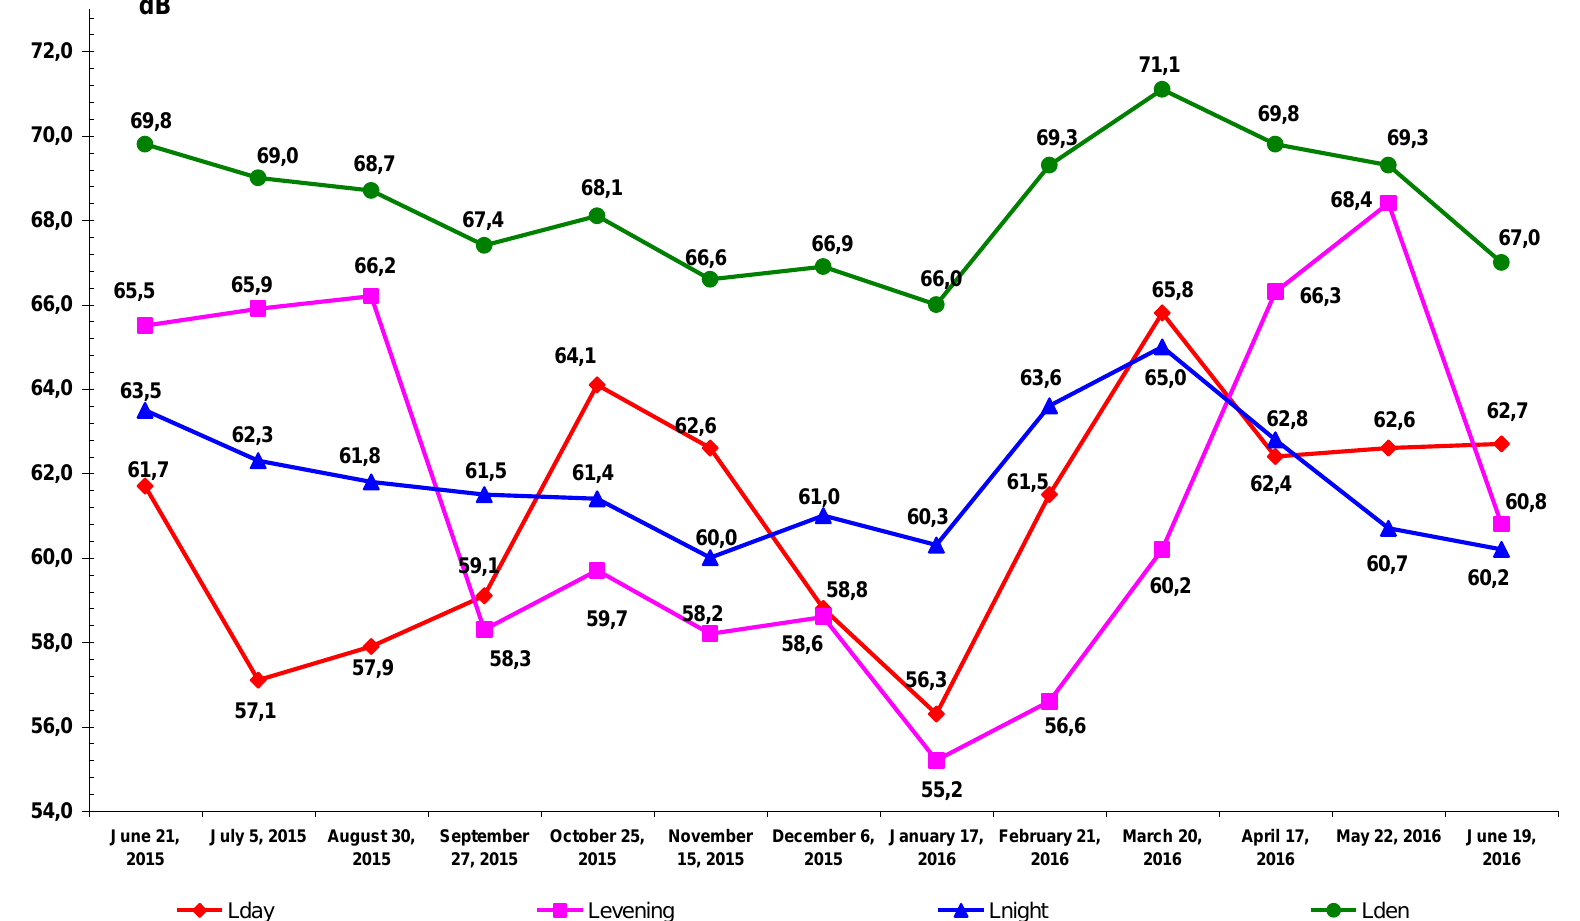
Chart 3. Values of basic noise indicators (L in the "zone of the city center and city roads" of the City of Novi Sad during the period 2012 −